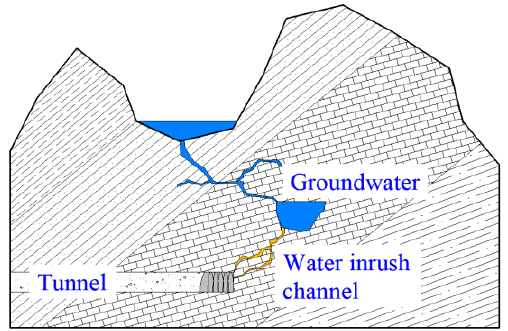
Figure 1. Water inrush in tunnel engineering.